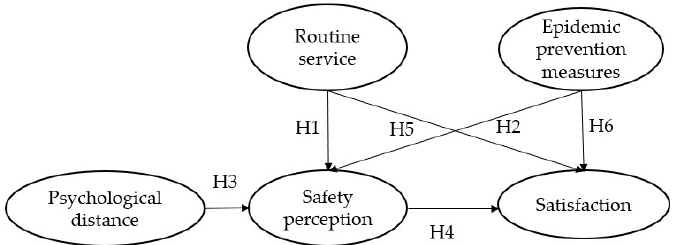
Figure 2. Conceptual model and assumptions. Note: H1–H6, Hypothesis 1–Hypothesis 6.